Question: Sum up the contents of this chart in one sentence.
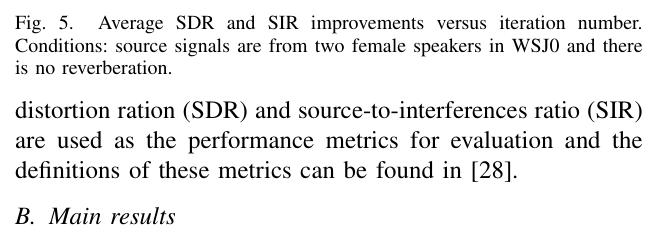
Answer: SDR and SIR improvements for the studied methods.